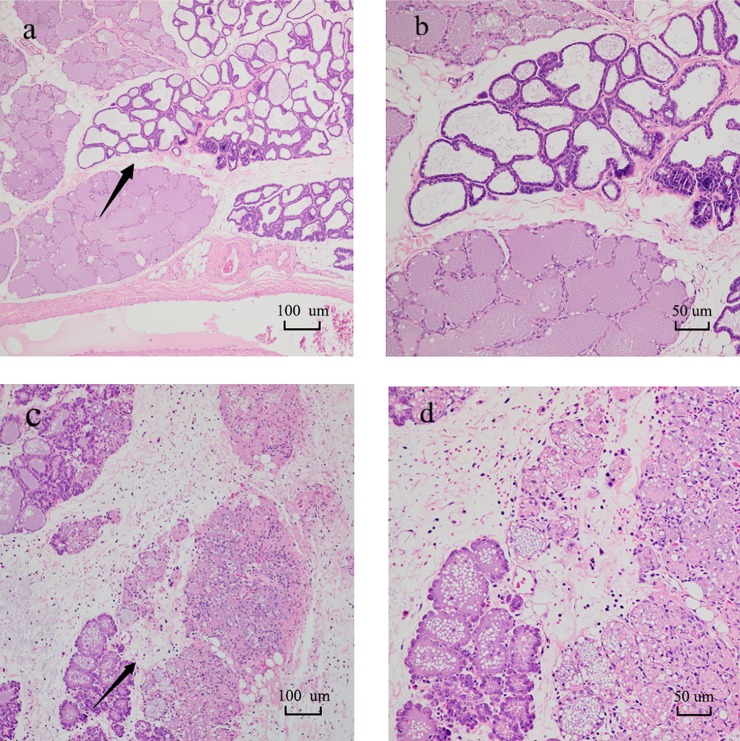
Results of H&E staining in rat mammary tissue for the blank group (a, b) and challenge group (c, d). Compared with a, the interlobular space of c was widened, accompanied by significant inflammatory edema and partial acinar atrophy, with acinar epithelial cells undergoing degeneration and necrosis and infiltration of neutrophils, macrophages, and lymphocytes. b and d (H&E×200) are enlarged images of the region designated by the arrows in a and c (H&E×100), respectively.